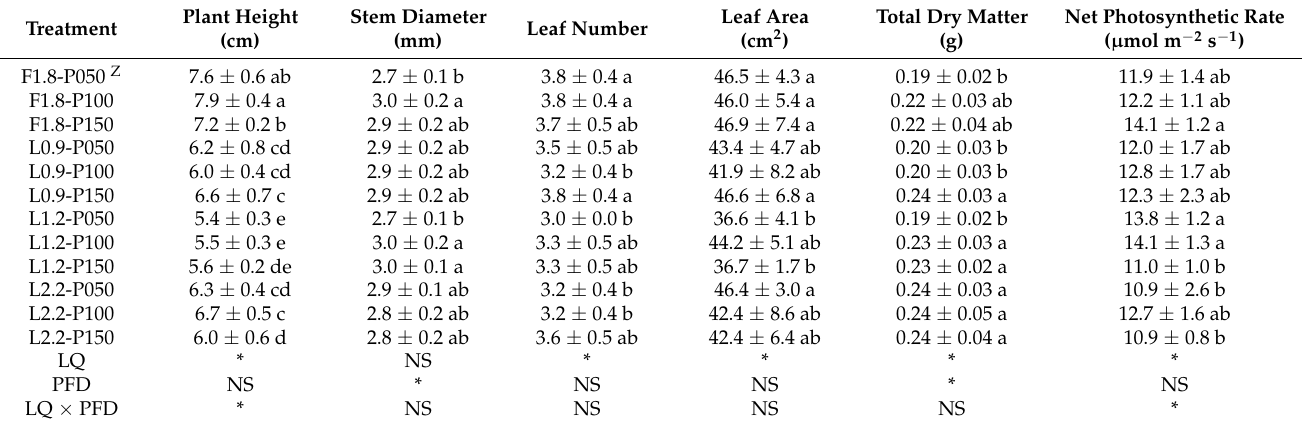
Table 2. Morphological characteristics, biomass and net photosynthetic rate (Pn) of grafted tomato transplants as affected by light quality (LQ) during the whole seedling period and photon flux density (PFD) in the healing stage. Different letters in the same column indicate significant differences at α = 0.05 level ( n = 6) according to Duncan’s test. NS and * represent nonsignificant and significant difference, respectively.